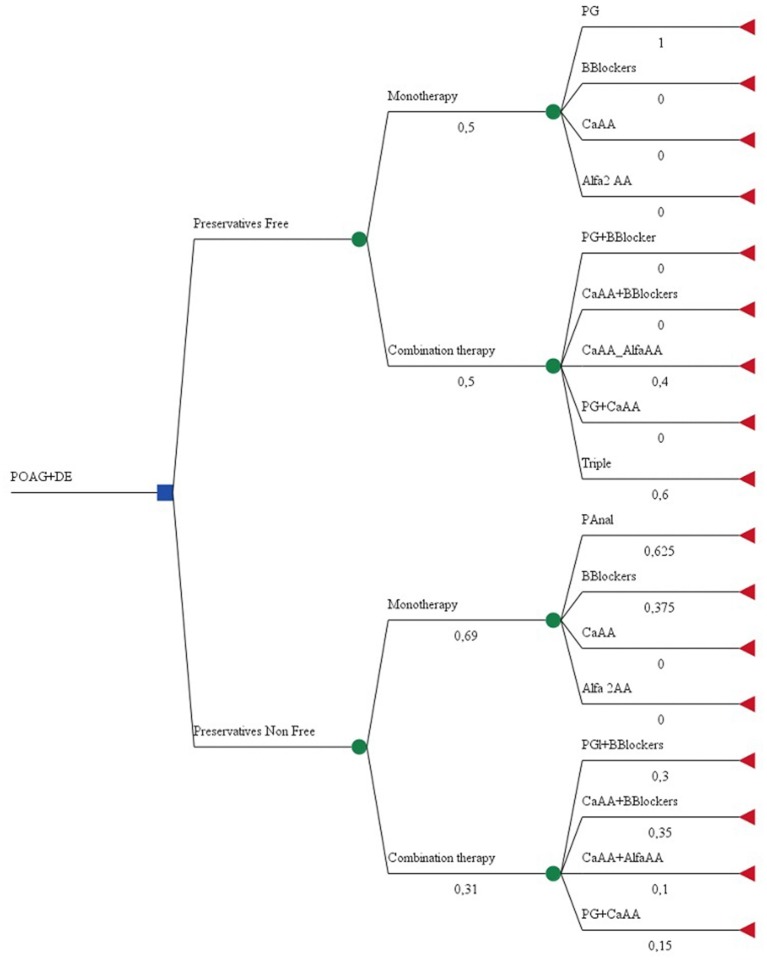
Decision tree model.